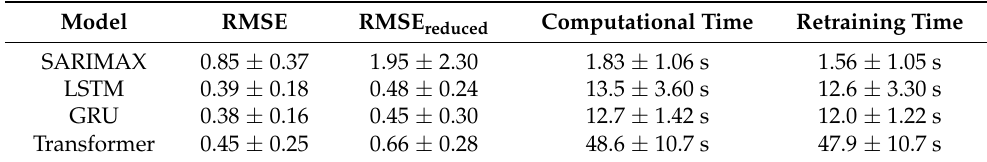
Table 6. In this table, the overall results are summed up for each model, reporting each mean value and its associated